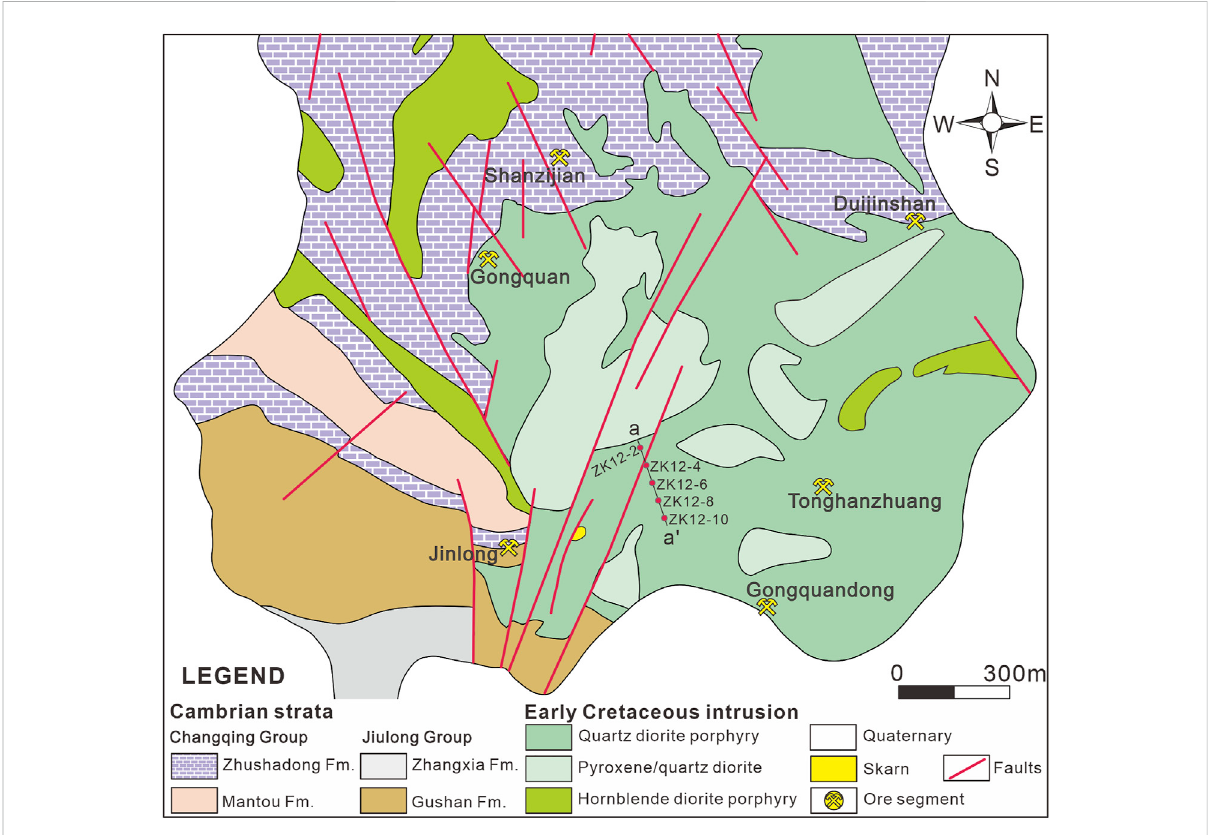
FIGURE 3 Geological map of the Yi ’ nan Tongjing Au – Cu deposit, modi fi ed after SDGM (2015) and Duan et al. (2020). The cross section of the exploration line (a-a ’ ) is shown in Figure